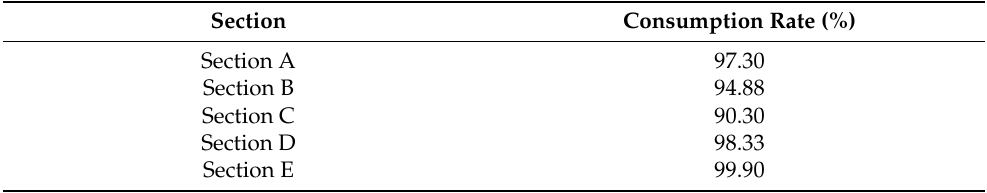
Table 2. Initial renewable energy consumption rates of the sections and main network.